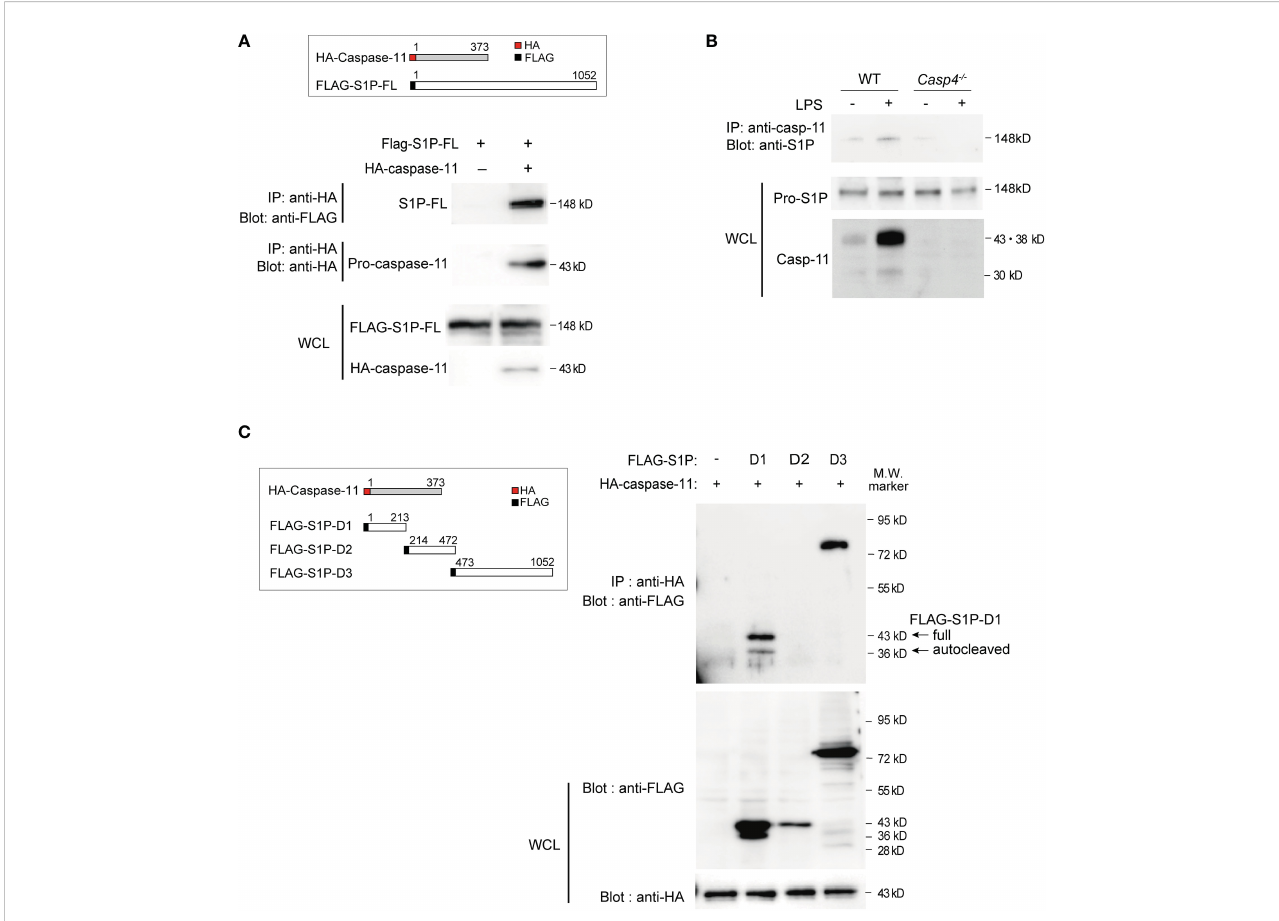
FIGURE 3 Caspase-11 interacts with S1P domains 1 and 3. (A) HEK293T cells were transfected with plasmids expressing HA-tagged mouse caspase-11 and full- length FLAG-tagged mouse S1P. Twenty-four hours after transfection, whole cell lysates (WCLs) were immunoprecipitated with HA antibody and immunoblotted with FLAG or HA antibody to detect the interaction between S1P and caspase-11. The protein expression levels of FLAG-tagged S1P and HA-tagged caspase-11 within the WCLs were detected by western blotting using anti-FLAG or anti-HA antibodies, respectively. (B) Endogenous S1P and caspase-11 protein directly interact. BMDMs were stimulated for 6 h with or without LPS before preparing whole cell lysates. The S1P protein pulled down by the caspase-11 antibody was detected by western blotting using an anti-S1P antibody. (C) HEK293T cells were transfected with HA-tagged mouse caspase-11 and deletion mutants of FLAG-tagged mouse S1P. FLAG empty vector was used as a control. Twenty-four hours after transfection, cells were harvested and WCLs were subjected to immunoprecipitation with anti-HA antibody and subsequent western blot analysis with anti-FLAG antibody. The protein expression levels of each FLAG-tagged S1P mutant and HA-tagged caspase-11 in the WCLs were shown by western blotting (bottom two blots). In cells transfected with plasmids expressing FLAG-S1P-D1 and HA-caspase-11, two bands were detected by the anti-FLAG antibody, corresponding to the full D1 fragment (43 kD) and an autocatalyzed form (36